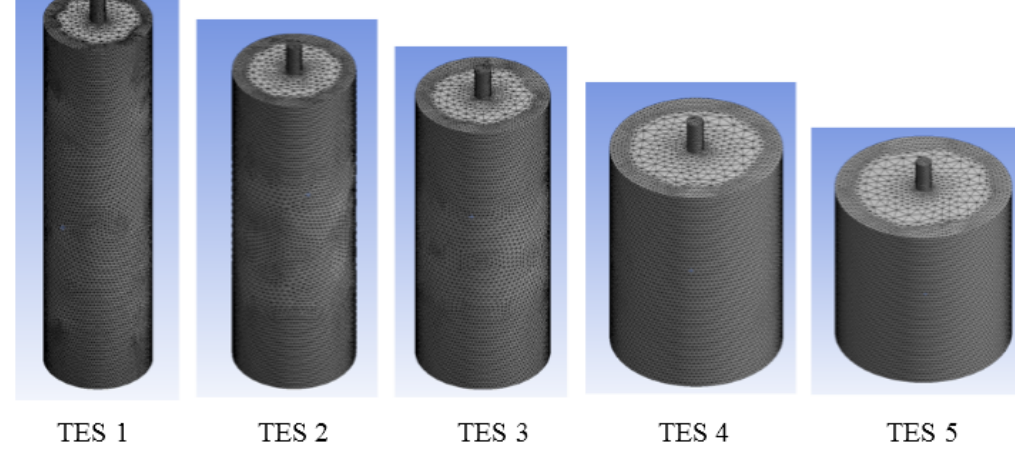
Figure 2. Meshed tanks used in TES